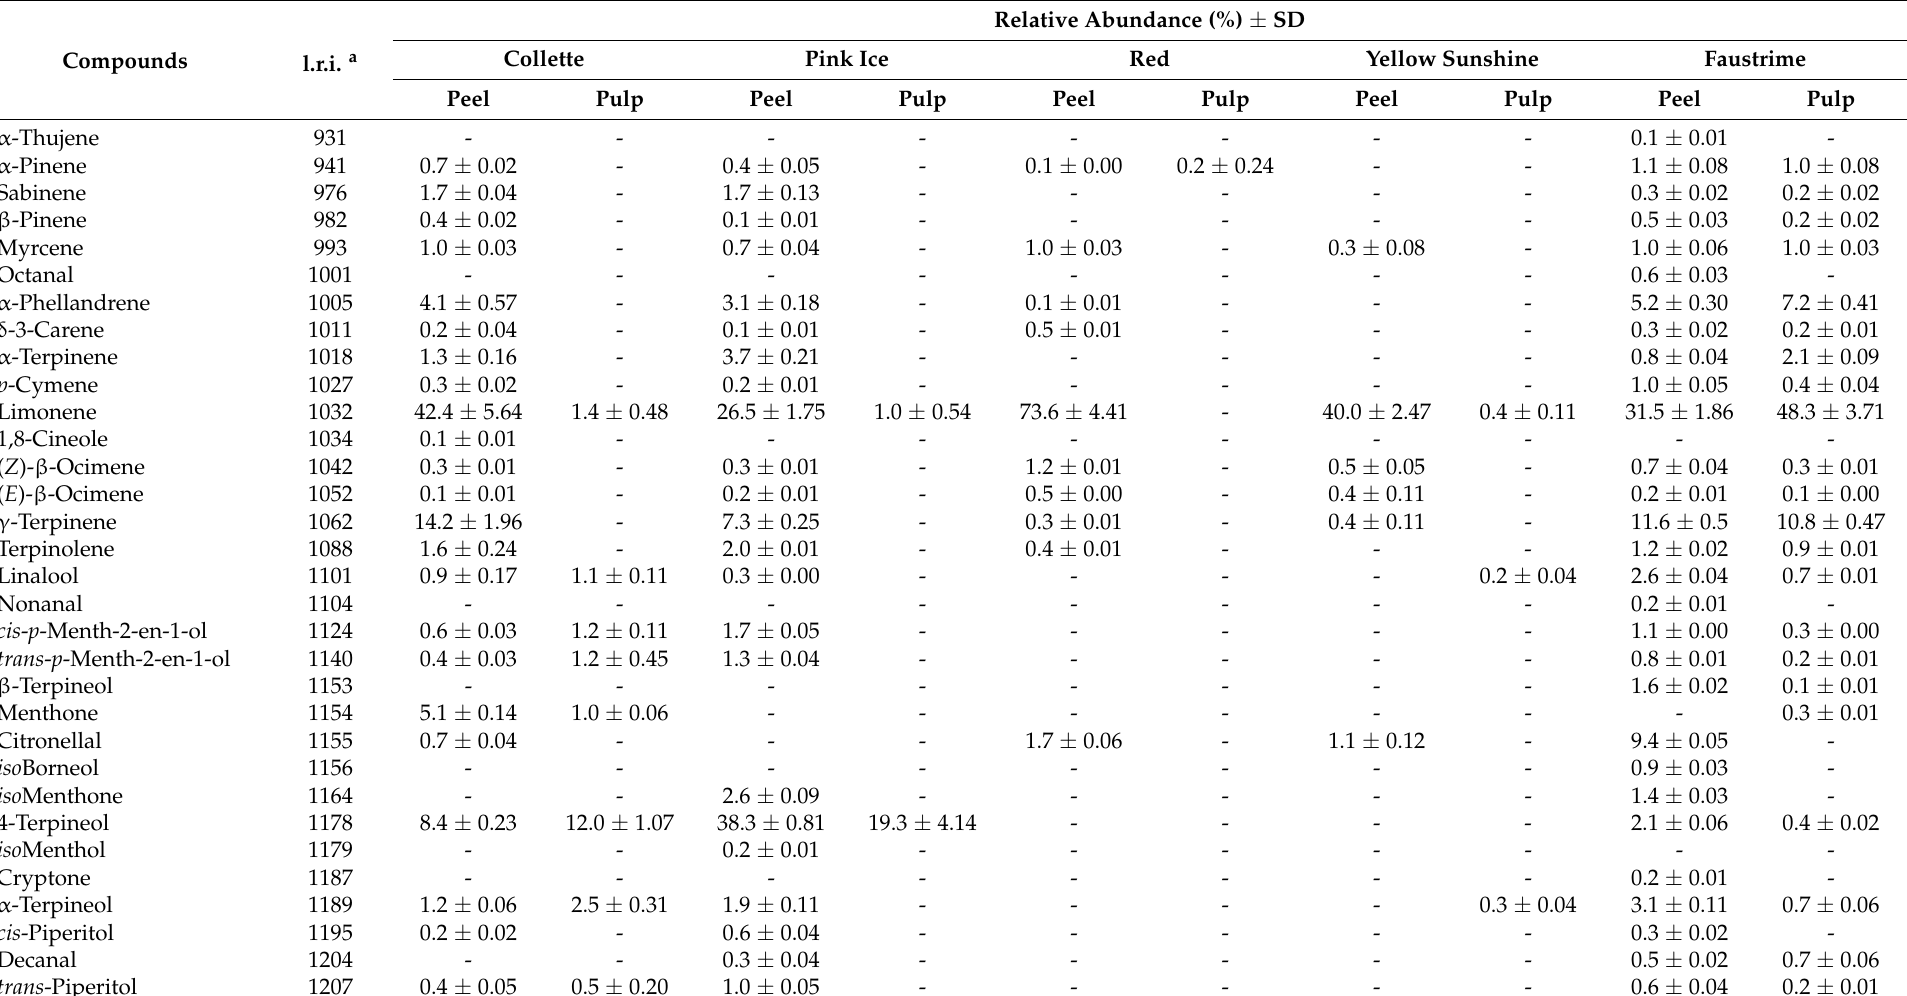
Table 4. Complete composition of the peel and pulp essential oils hydrodistilled from all of the analysed Citrus australasica varieties (Collette, Pink Ice, Red, and Yellow Sunshine), and for the Faustrime